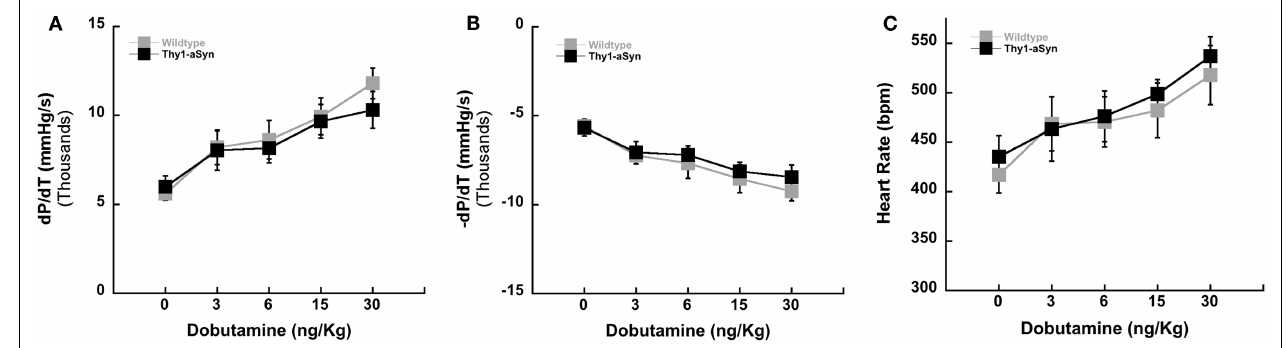
FIGURE 2 | Left ventricular contractility inWT ( n = 7) andThy1-aSyn ( n = 7) at 9–12months of age . Left ventricular positive dP / dT [contractility; (A) ], left ventricular negative dP / dT [relaxation; (B) ], and heart rate following administration of the β -adrenergic agonist dobutamine [ (C) ; mixed design ANOVA].